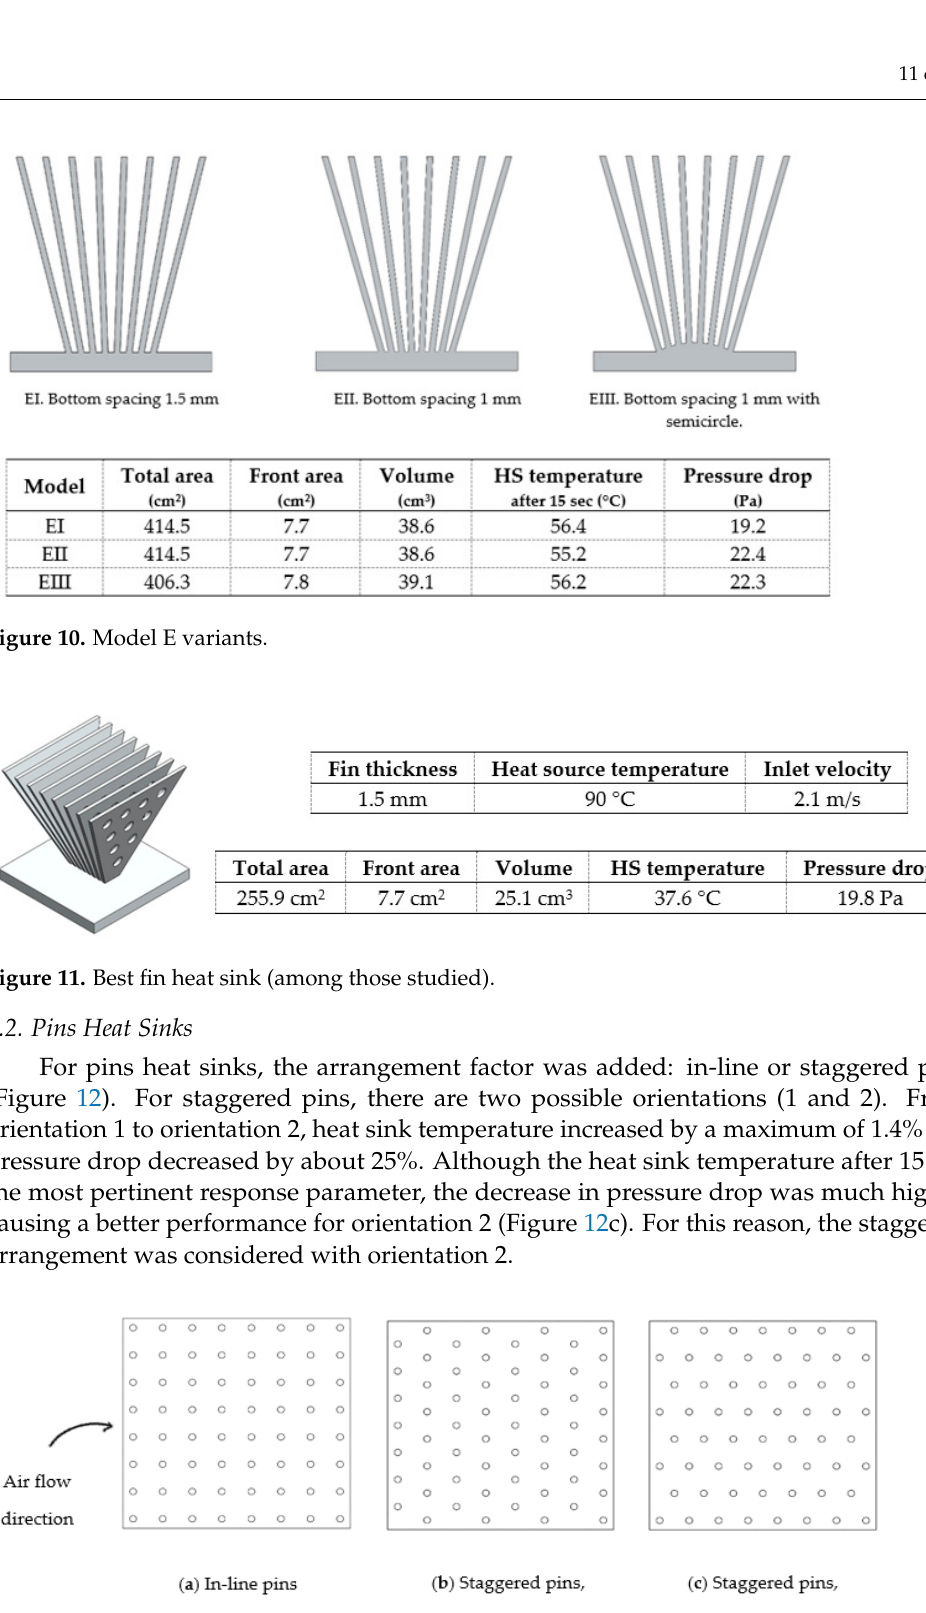
Figure 12. Results for the possible pin heat sinks arrangements and orientations.